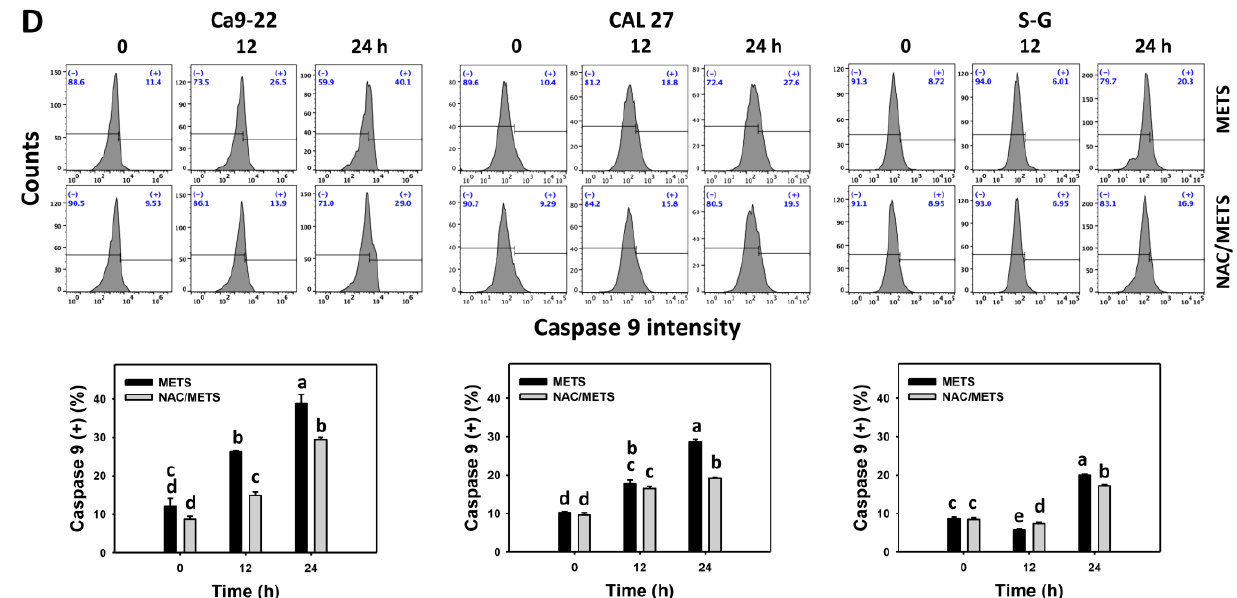
Figure 6. METS leads to Cas 8 and 9 activations in oral cancer cells. ( A , C ) Caspases 8 and 9 histogram changes. Cells were treated with METS for 24 h. Oral cancer (Ca9-22 and CAL 27) and normal cells (S-G) were included. (+) indicates a high intensity of caspases 8 and 9. ( B , D ). NAC response on caspases 8 and 9 activations. Untreated control and NAC pretreatment were followed by posttreatment of vehicle control and METS (2 and 6 μg /mL) for 0, 12, and 24 h, i.e., control, NAC, METS, and NAC/METS, respectively. Data = mean ± SD ( n = 3). Data showing non-overlapping lower-case letters show significant results ( p < 0.05) as analyzed by the one-way ANOVA analysis and post hoc test.